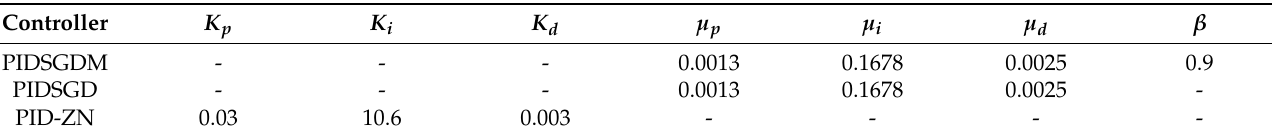
Table 5. Controllers obtained